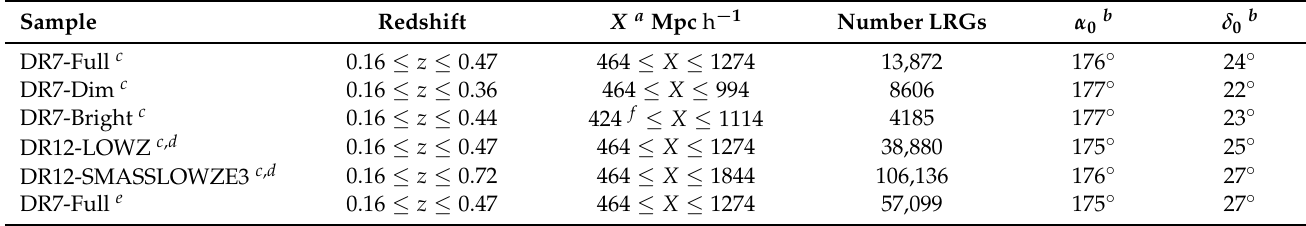
Figure 5. Same as the right panels of Figure 3 but for the subsamples DR7-Dim ( left panel ) and DR7-Bright (( right panel ); see Table 1 and text for details). The gray stripe near the power spectrum, plotted for DR7-Bright, demonstrates error bars, calculated by the jackknife technique. Table 1. SDSS LRG (DR7) and (DR12)